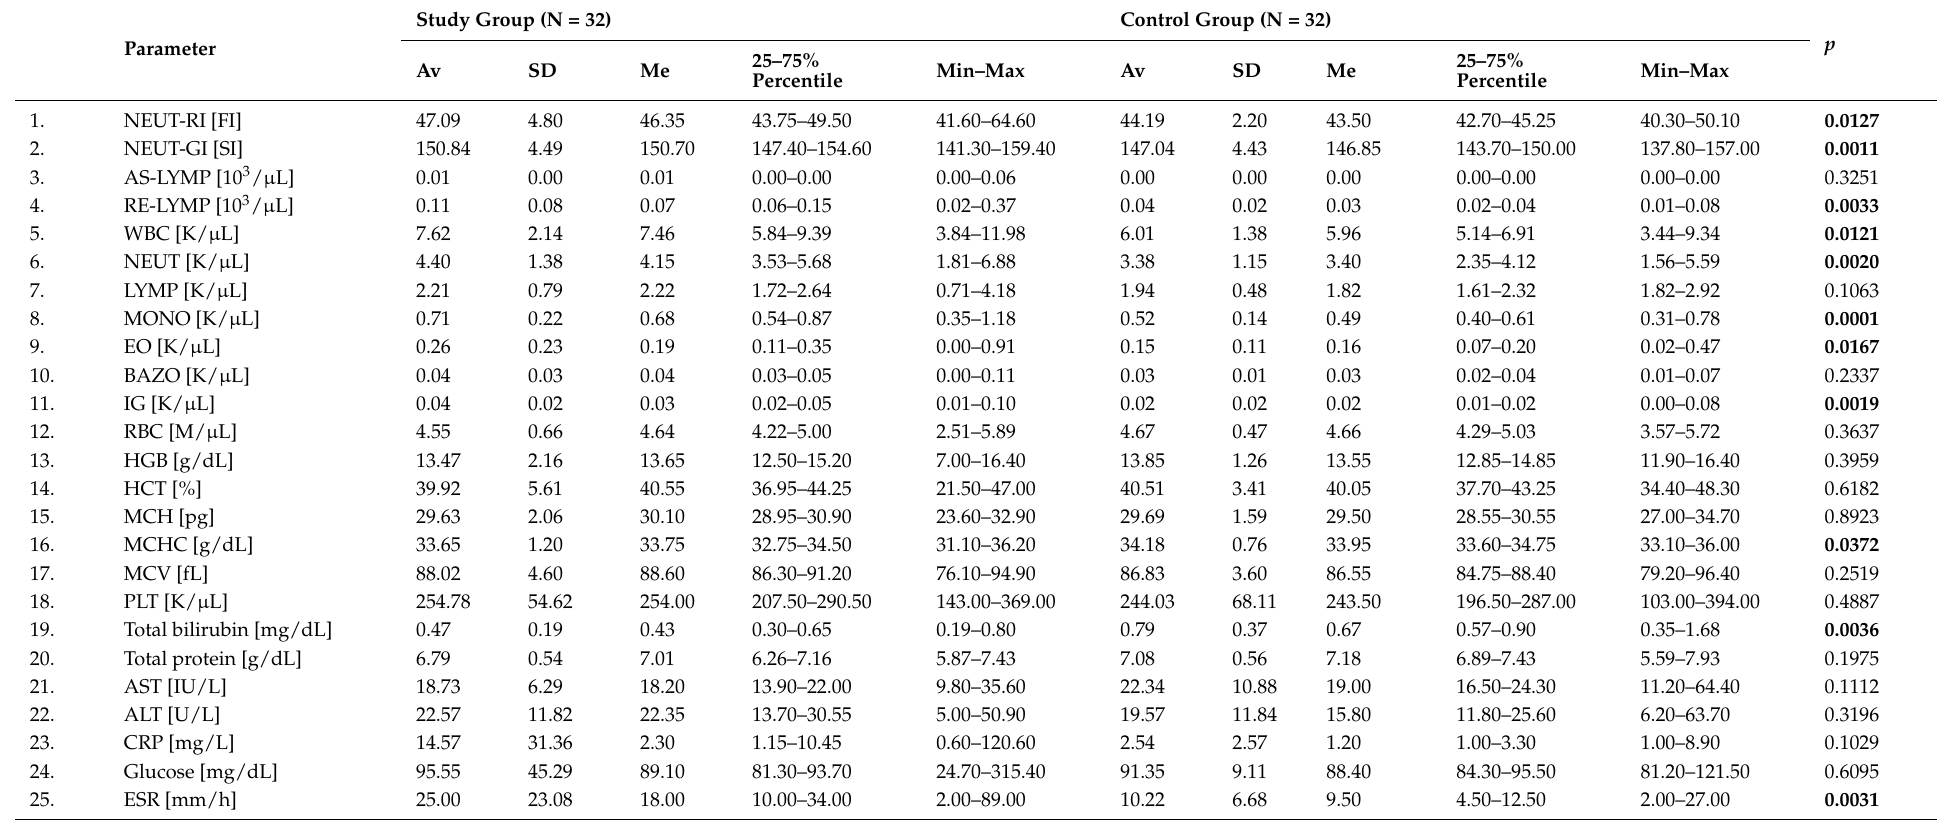
Table 2. Statistical characteristics of biochemical and haematological parameters in patients with pemphigus (GP) and control group